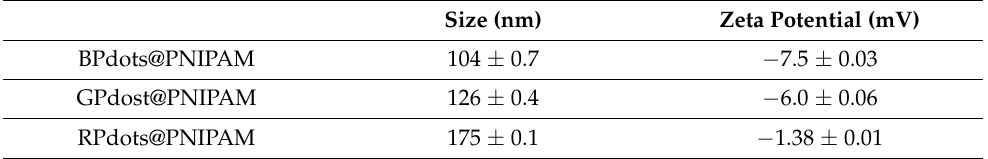
Figure 3. ( a ) UV-vis and ( b ) fluorescence spectra of BPdots@PNIPAM ( ■ ), GPdots@PNAIPAM ( ● ), and RPdots@PNAIPAM ( ▲ ) in water at 25 °C. Excitation wavelength 350 nm. Table 3. DLS results of